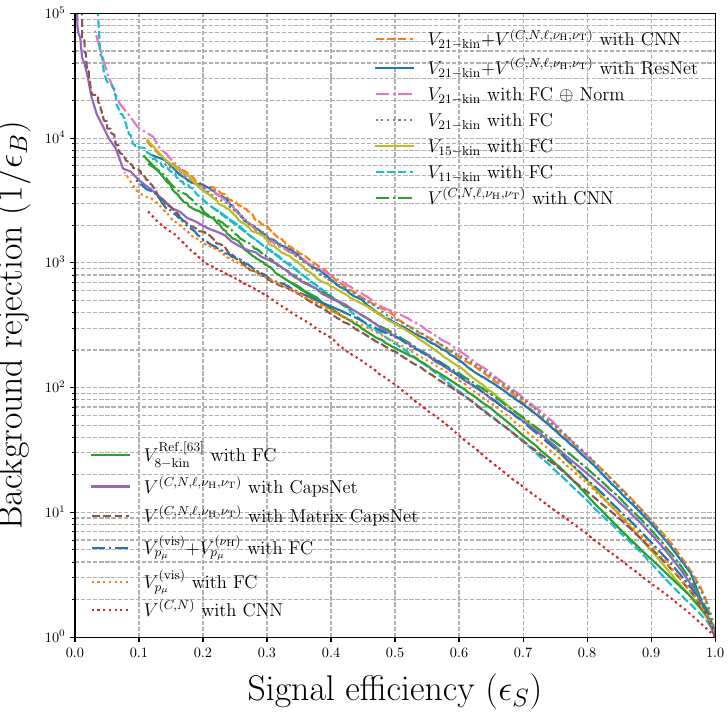
Figure 14 . ROC curves for selected NN architectures evaluated on the same test sample.